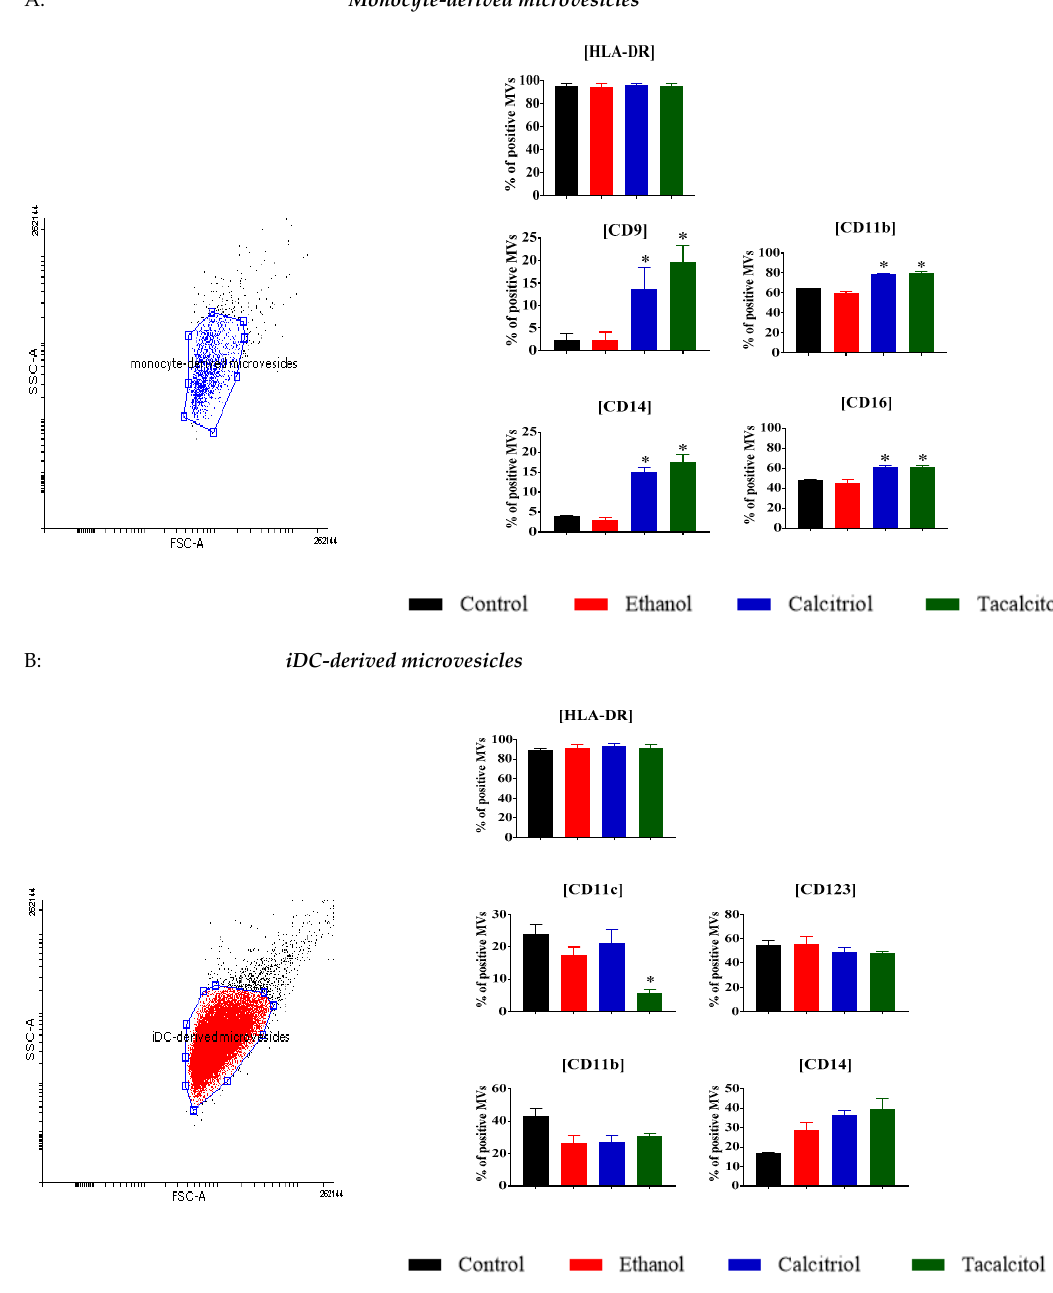
Figure 4. Characteristics of monocyte-derived and myeloid iDC-derived MVs: ( A ) distribution of differentiation markers of monocytes-derived MVs by flow cytometry analysis. Mean values and standard deviation are presented. Statistical analysis: Sidak’s multiple comparisons test; significant differences as compared with ethanol (* p < 0.005). The graphs represent data from at least three separate experiments; ( B ) distribution of differentiation markers of myeloid iDCs-derived MVs by flow cytometry analysis. Mean values and standard deviation are presented. Statistical analysis: Sidak’s multiple comparisons test; significant differences as compared with ethanol (* p < 0.005). The graphs represent data from at least three separate